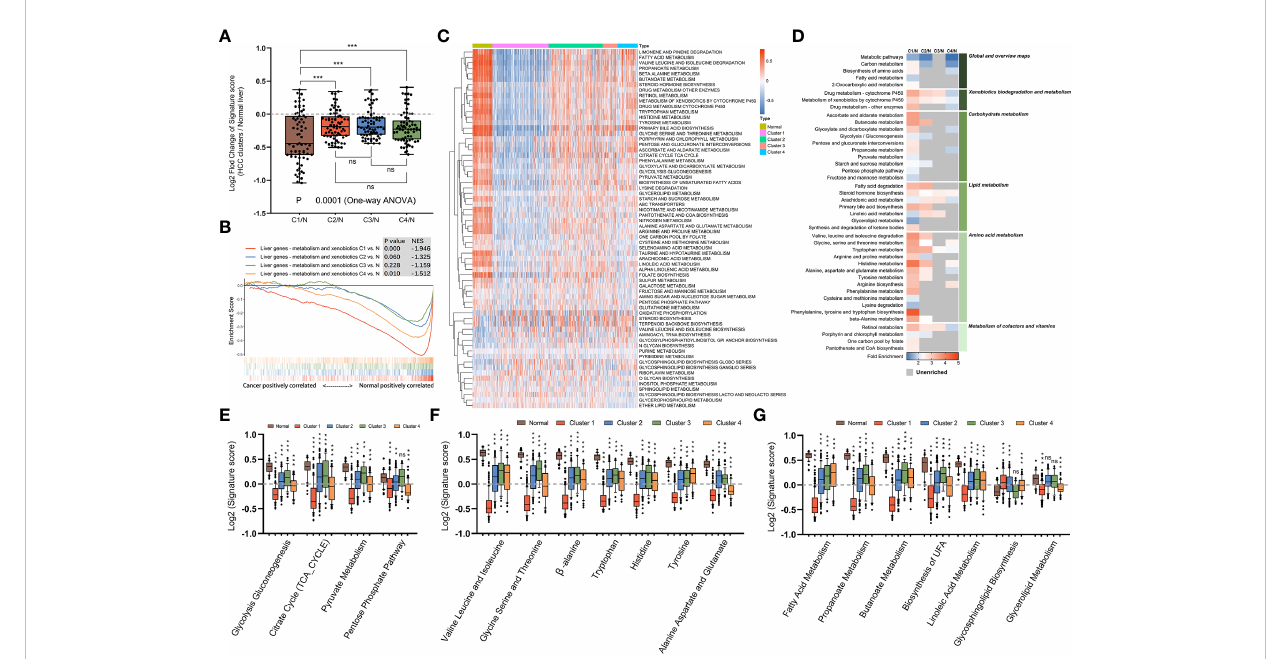
FIGURE 3 Metabolic landscape across metabolic subgroups. (A) In samples of normal livers and each subtype, the GSVA values of 69 KEGG metabolic pathways were measured respectively. With the normal liver as the control group, fold changes of GSVA values in each subtype were obtained and shown in a box plot. Each dot represents the fold change in GSVA value of one metabolic pathway between a subtype and the control group. (B) Gene set enrichment analysis of a gene sets including metabolic genes in healthy liver, with all transcripts ranked by the log2 (Fold Change) between clusters and normal liver. (C) Heatmap depicting GSVA values of metabolic pathways across each subgroup. (D) Heatmap showing the results of KEGG clustering results based on differentially expressed genes in each subgroup. (E – G) The GSVA values of pathways involved in glucose metabolism (E) , amino acid metabolism (F) , and fatty acid metabolism (G) for samples in each subgroup were shown in box plots. (ns: not signi fi cant, **: P < 0.01, ***: P <